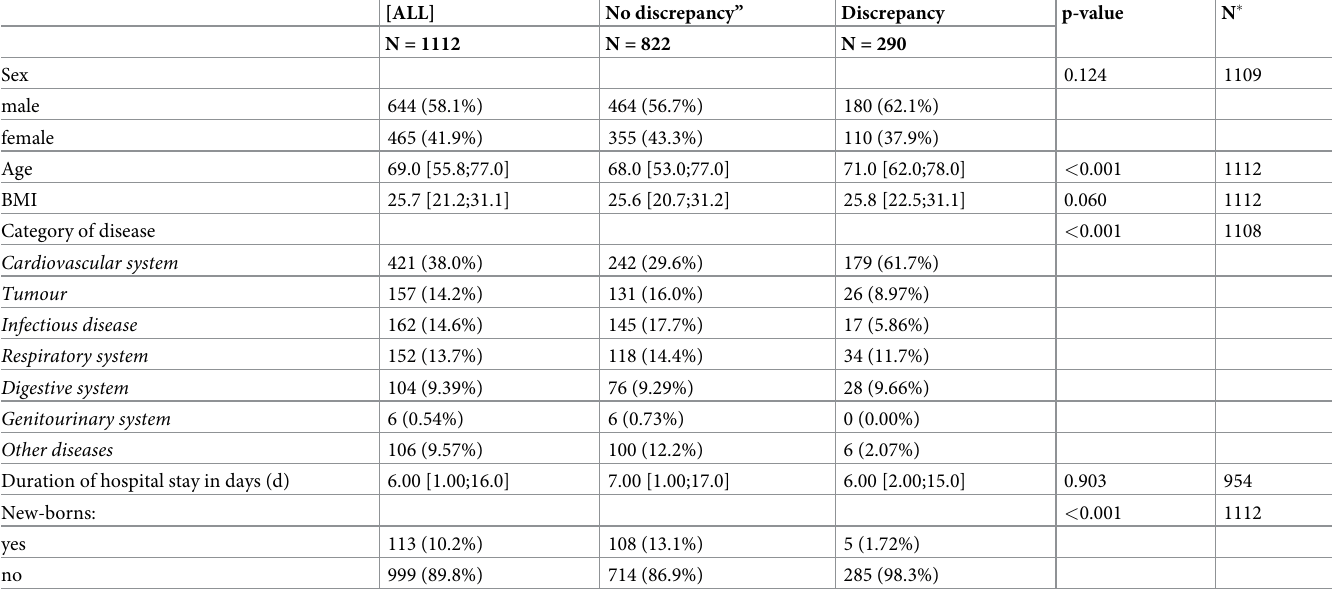
Table 1. Baseline characteristics in the total cohort, illustrating medians (25% quantiles; 75% quantiles), absolute frequencies (%) and p-values originating from Mann-Whitney U tests for continuous variables, Chi-square tests and the clinical characteristics of the group of patients.